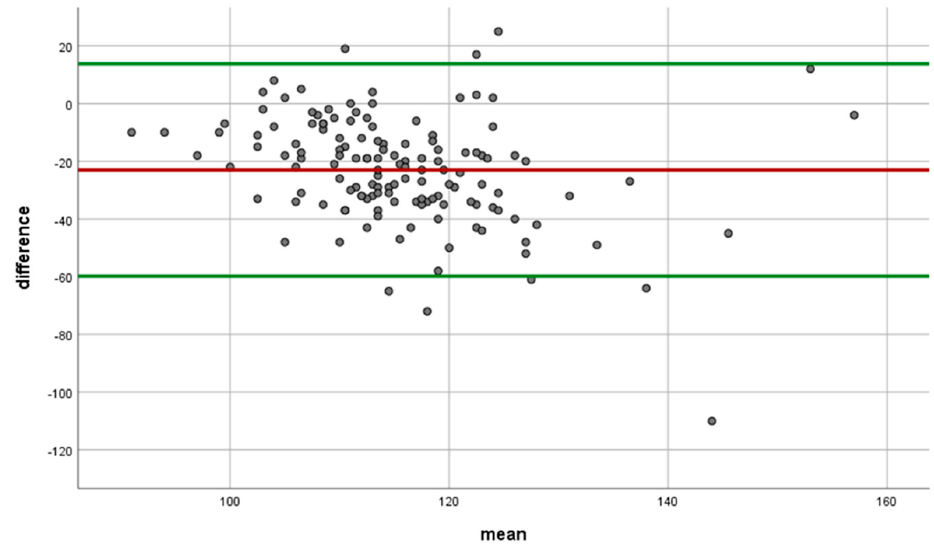
Figure 3. Bland–Altman chart of Spectralis and Revo80 measurements for Global RNFL, where ◦ is difference, – mean, and – lower and upper 95% limit values.